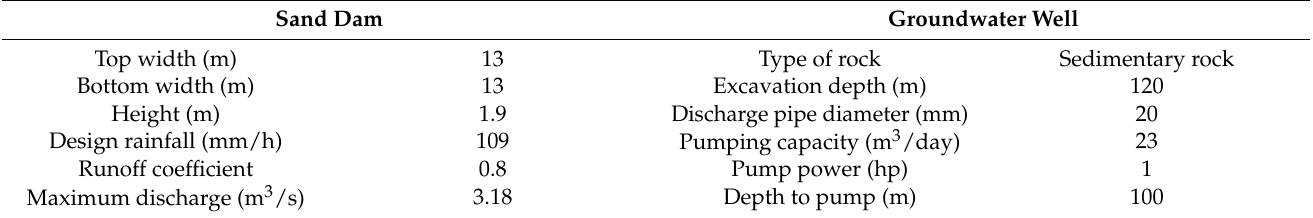
Table 1. Characteristics of the sand dam and groundwater well.